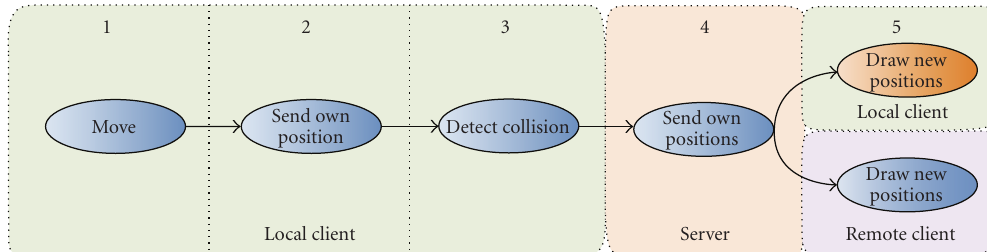
Figure 10: Server-side collision handling.